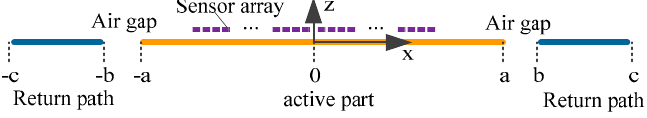
Figure 2. Lateral view of the y -direction exciting coil and sensor array.